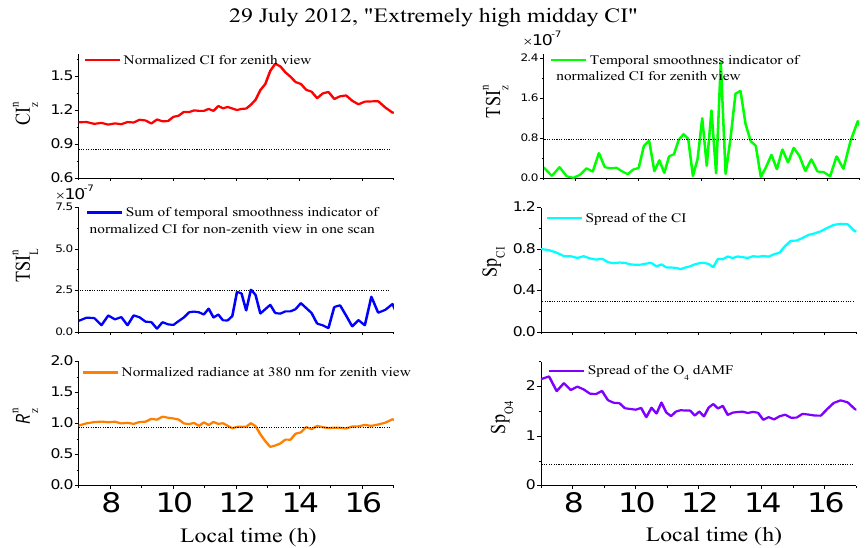
Figure 8. Time series of the quantities (same as in Table 1) derived from the MAX-DOAS cloud classification scheme on 29 July 2012, categorized as “extremely high midday CI”. The dashed line presents the thresholds of each quantity. As indicated in Fig. 9, this day was completely cloudy over Wuxi.